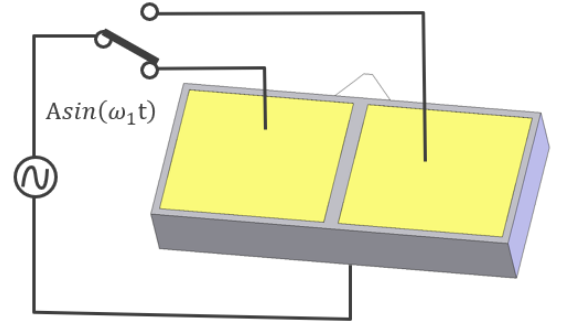
Figure 3. One source driving of the stator. During single source drive, only one of the electrodes on the piezoelectric plate is exposed to one sinusoidal voltage at a frequency of ω 1 . Changing the excited electrodes changes the moving direction of the slider.